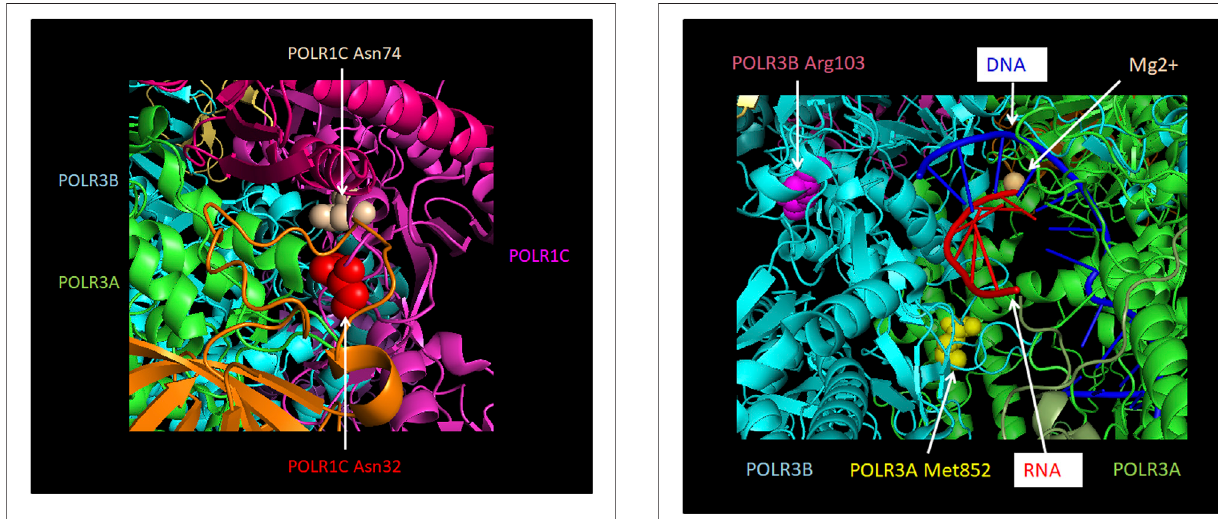
FIGURE 6 | Localization of POLR3A Met852Val and POLR3B Arg103Hismutationsrelativetotheactivesite.POLR3Aisshowningreenand POLR3B in turquoise. Pol III mutations described in the text that are found close to the active site and which may thus affect catalytic activity are depicted. Methionine 852 of POLR3A as part of the bridge helix is highlighted as a sphere in yellow. Arginine 103 of POLR3B is highlighted as a sphere in magenta.RNAisshowninredandDNAinblue.TheMg2+ionoftheactivesite isshown asasphere in lightorange. TheFigure wasmodi fi edfrom PDB7AE3 by employing